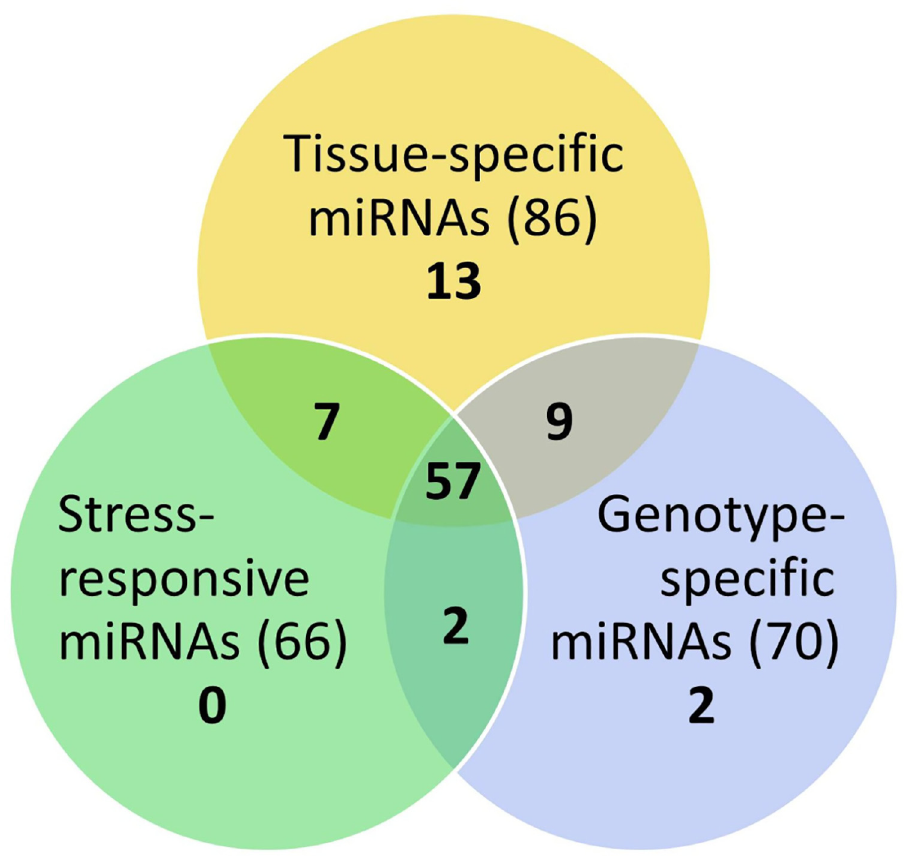
Fig 4. Venn diagram of all differentially expressed conserved microRNAs identified through Approach #1. The number of microRNAs that were differentially abundant in each category is indicated. A total of 57 conserved miRNAs were identified as being responsive to water deficit stress, as well as being differentially abundant across different genotypes and tissue types.